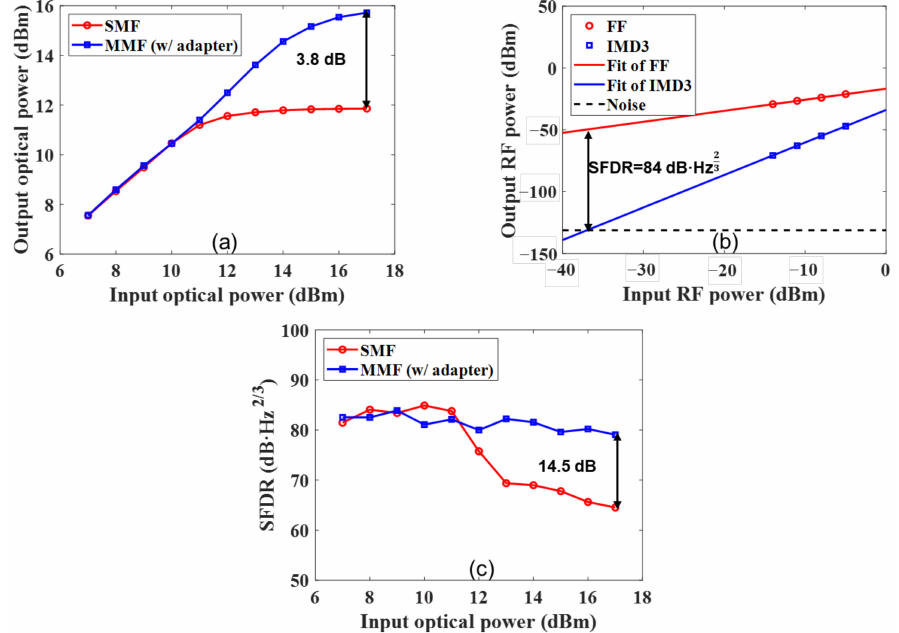
Figure 4. ( a ) The output optical power vs. input optical power. ( b ) Detected FF and IMD3 powers in SMF photonic links when input optical power is 8 dBm, as an example of measuring SFDR. ( c ) SFDR vs. input optical